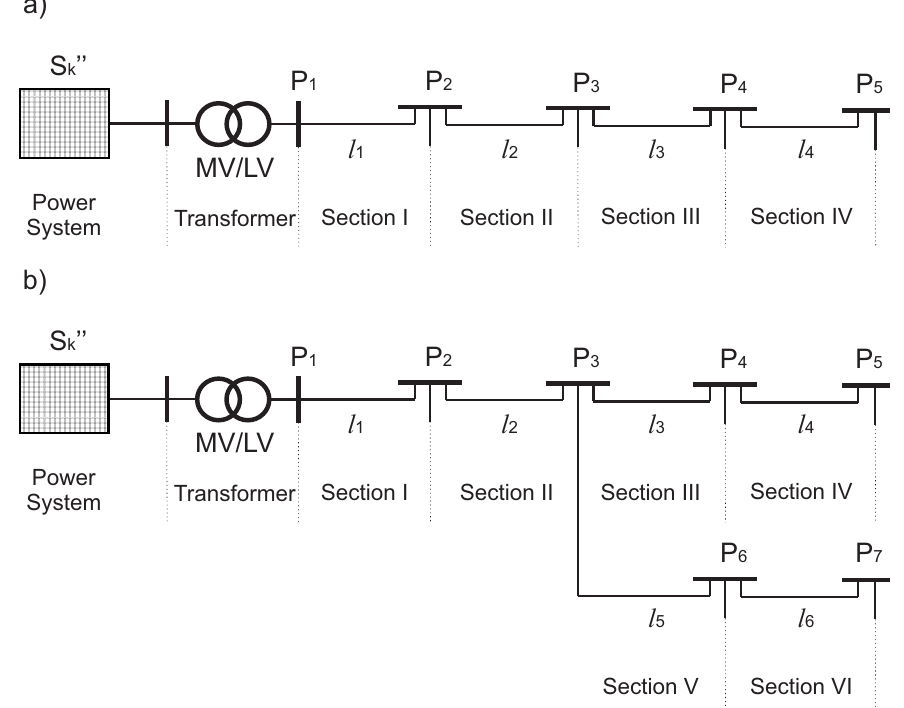
Figure 6. Low-voltage power grid configurations selected for testing: ( a ) radial topology, ( b ) branch- ing radial topology.